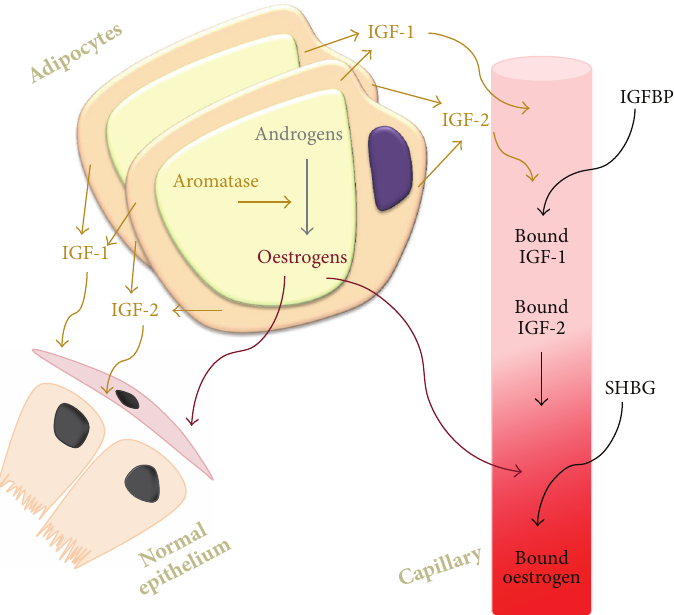
Figure 3: Adipose tissue as an endocrine organ. Adipocytes express enzymes involved in steroid metabolism, notably 17 𝛽 -hydroxysteroid dehydrogenase and aromatase which converts androgens into oestrogens. There is a resultant increase in paracrine concentrations of oestrogens and a significant increase in the concentration of circulating oestrogens in obese men and in obese postmenopausal women compared to nonobese individuals. In the blood, oestrogen is complexed with sex hormone-binding globulin (SHBG). Adipocytes secrete severalproteinhormonesincludingIGF-1andIGF-2.IGF-1andIGF-2enterthebloodstreamwheretheycanbeboundbyinsulin-likebinding proteins (IGFBPs). Local concentrations of IGF-1 and IGF-2 may be particularly high and are unlikely to be reduced by feedback